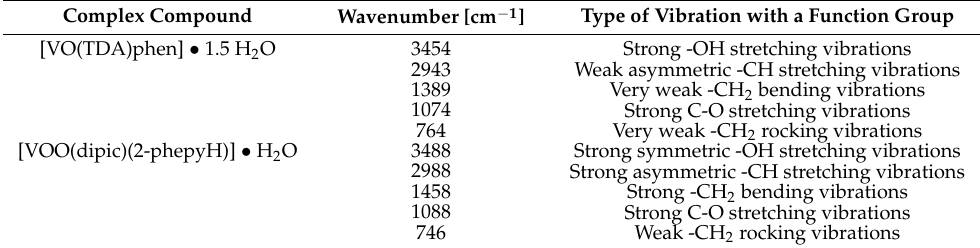
Table 1. The results of FTIR spectroscopy for the products of 3-buten-2-ol